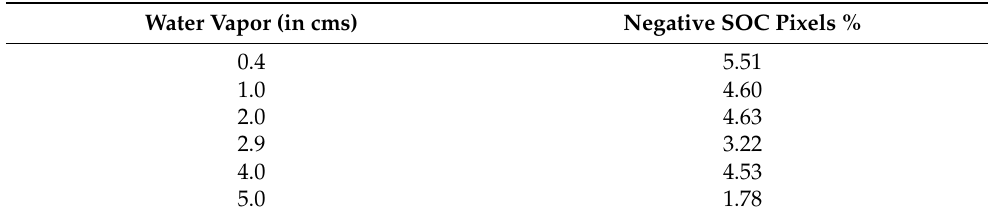
Table 7. Percentage of negative SOC estimated using Hyperion data corrected by ATCOR, from both the sites.